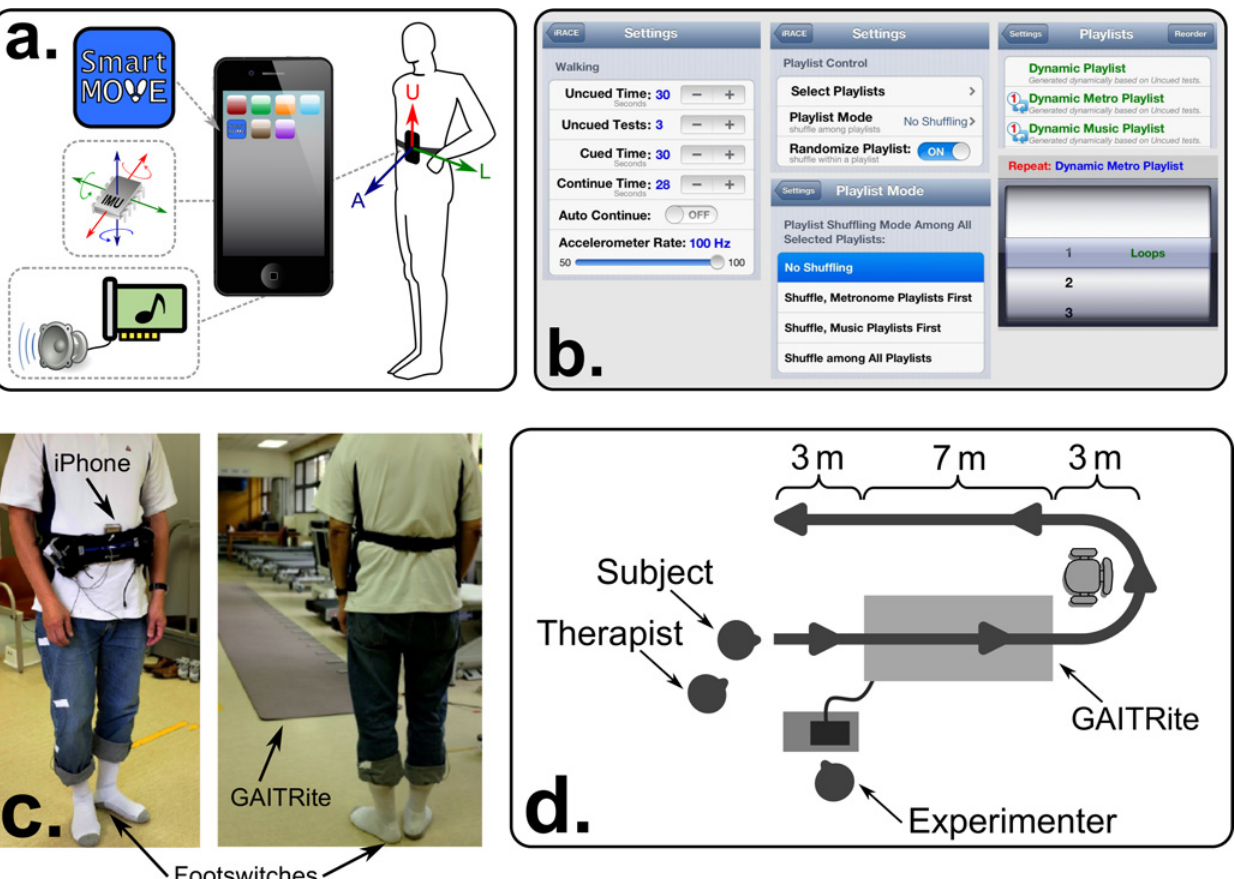
Fig 1. Key experimental features. The SmartMOVE mobile app (a.) utilizes the smartphone ’ s inertial measurement unit to record gait movements during walking. Flexible parameter settings (b.) enable precise control over testing parameters. SmartMOVE outcome measures were validated against heel- mounted footswitches and a GAITRite sensor walkway (c.) while subjects walked along a prescribed path